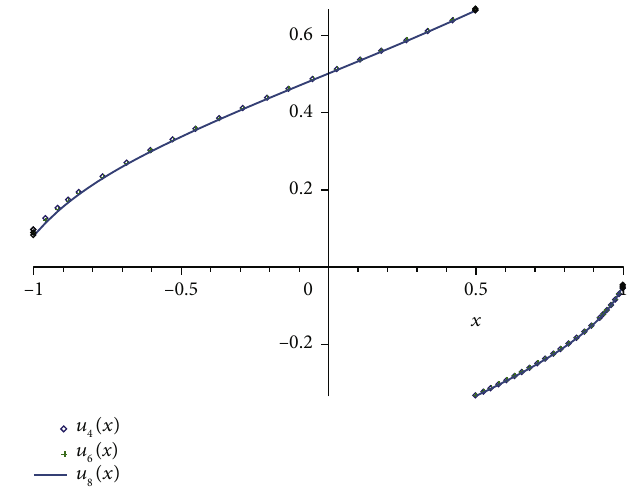
Figure 4: The graph of approximate solutions u